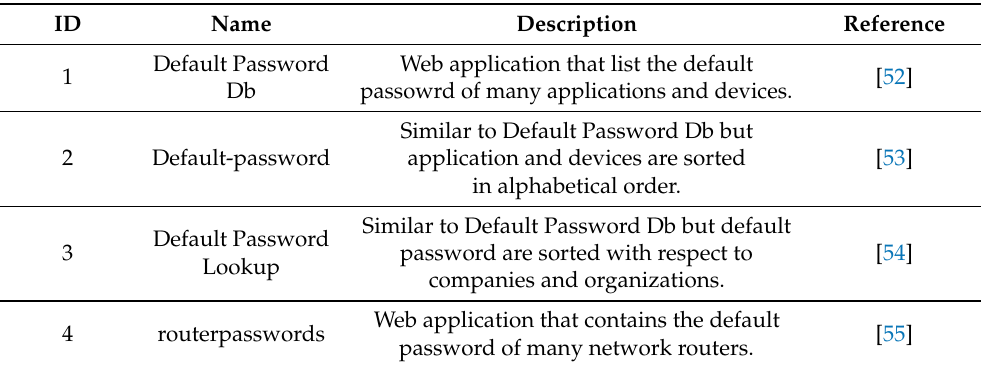
Table 10. Tools used for OSINT on default